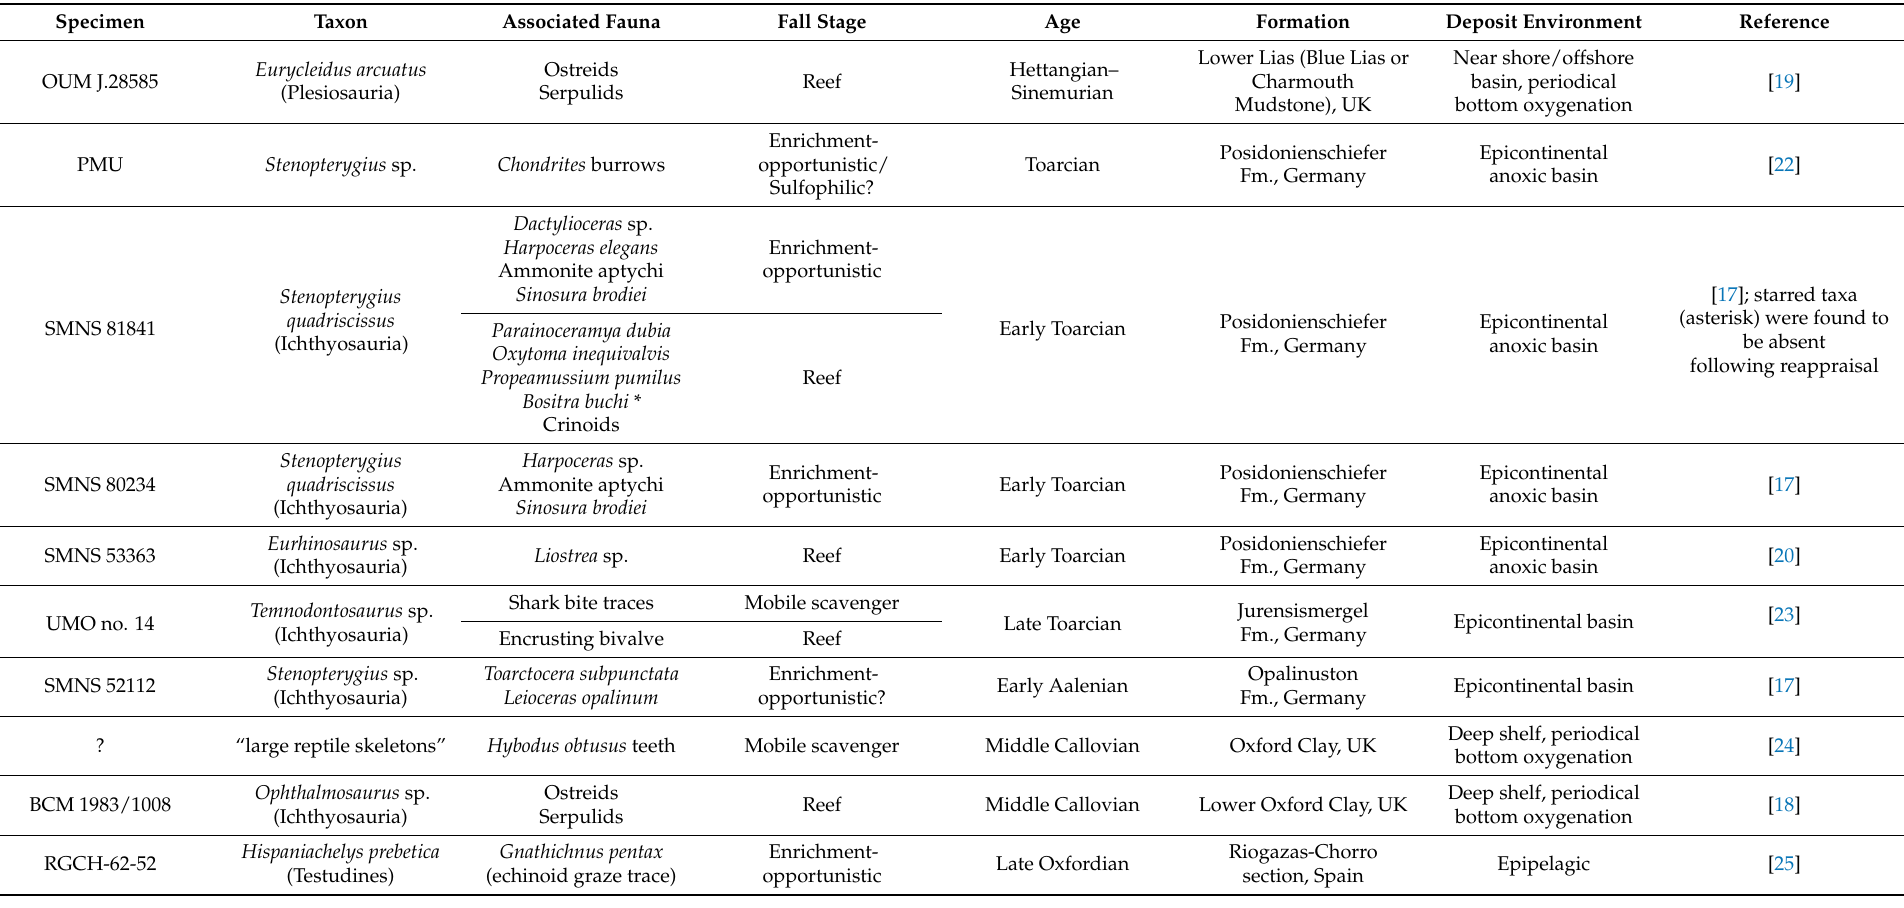
Table 1. Review of previously published Jurassic deadfall